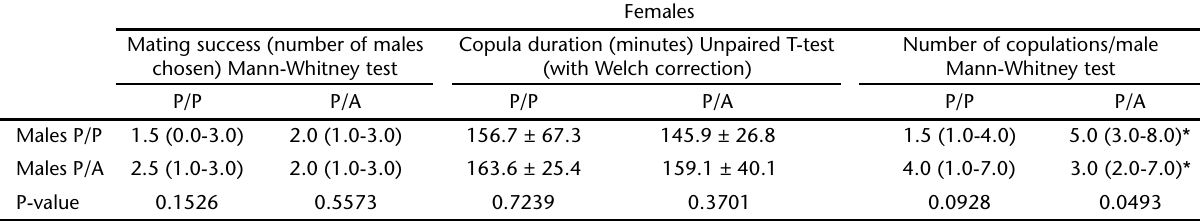
Table II. Influence of adult protein ingestion on mating success, copula duration, and number of copulations of males of C. capitata exposed to females fed protein-rich and no-protein diets. Either the median (mating success and number of copulations/male – range of variation indicated between brackets) or the mean ± standard deviation (copula duration) are represented. (P/P) Protein present in diet, (P/A) protein absent in diet. The pair (in column) with an asterisk was the only to present statistical